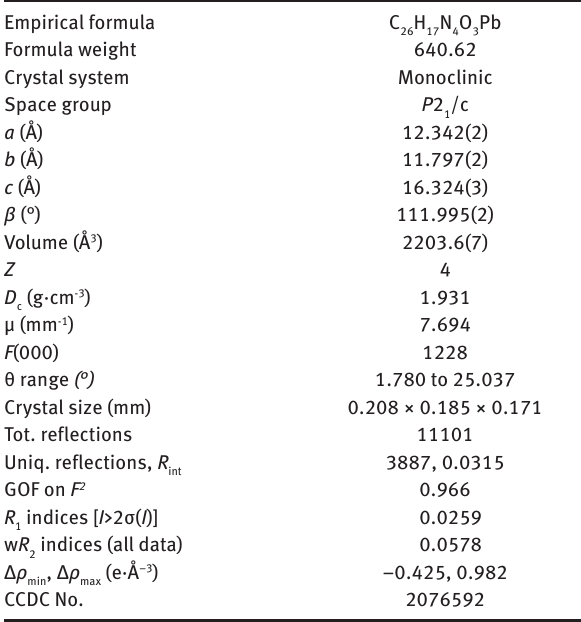
Table 2: Crystalline data and refinement parameters for complex 1 Empirical